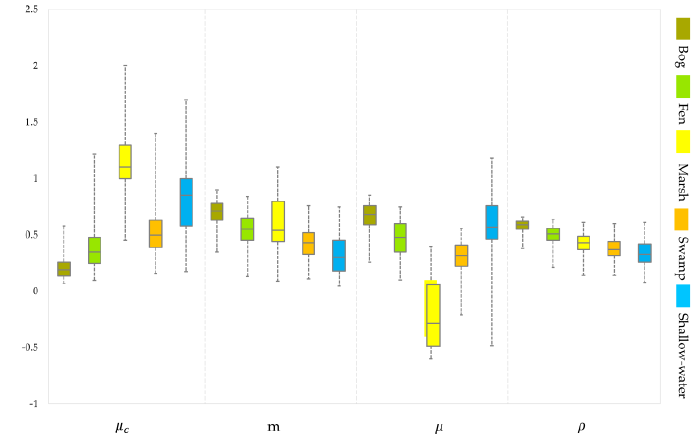
Figure 8. Box-and-whisker plots for extracted features from the CP SAR data for wetland classes obtained from pixel values of the training data set. Note: µ c : circular polarization ratio, m : degree of polarization, µ : conformity coefficient, and ρ : correlation coefficient.